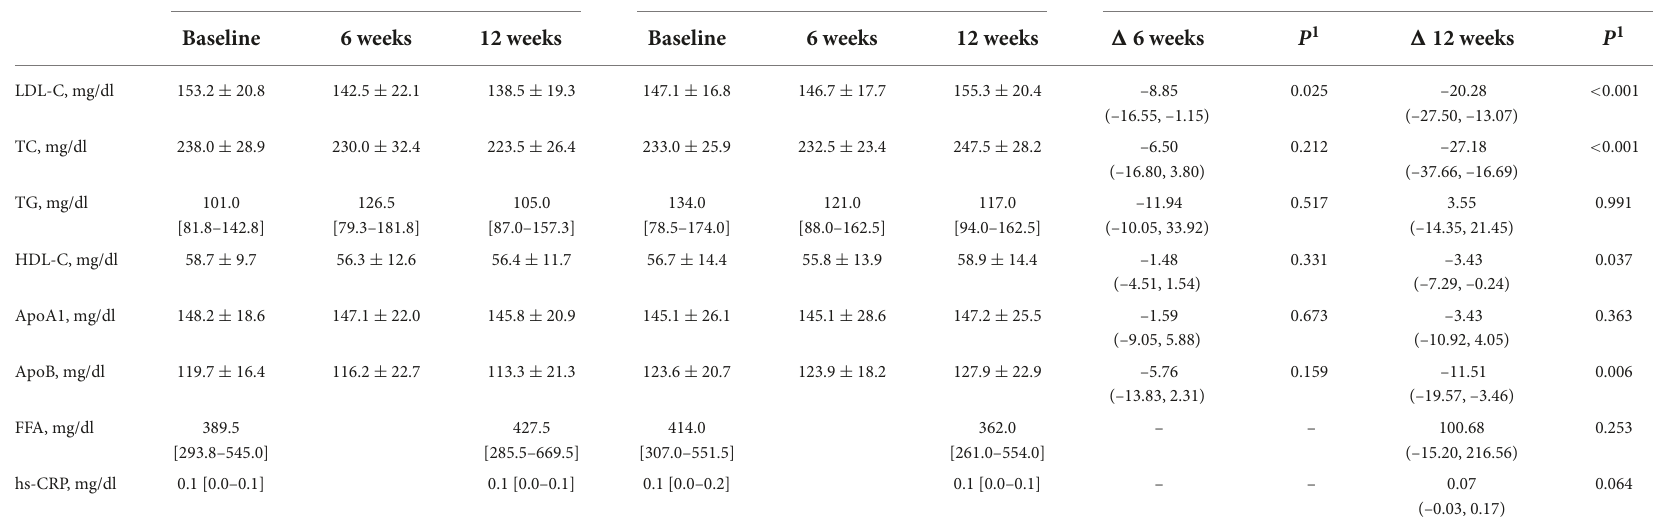
TABLE 4 Primary and secondary outcome measures of the two groups (per protocol